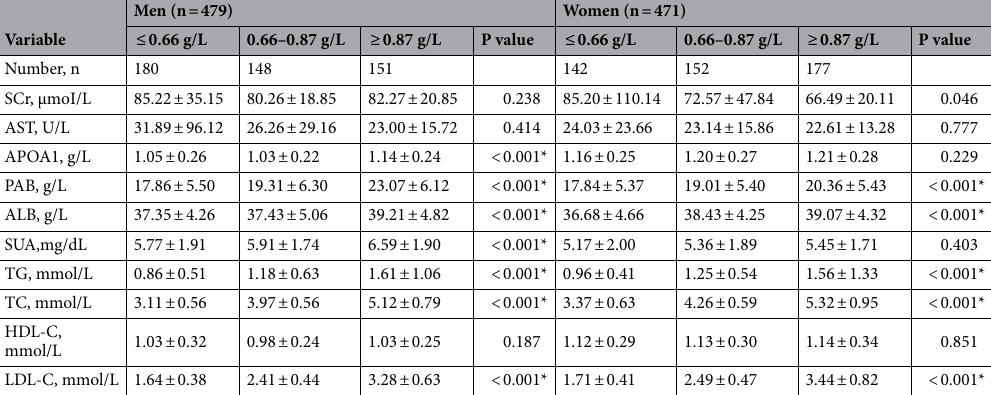
Table 5. One-way ANOVA for subgroups to investigate the association between APOB levels and metabolic factors in AF patients. Data were presented as mean ± SD. Abbreviations as in Table 1. *Statistically significant value (P <